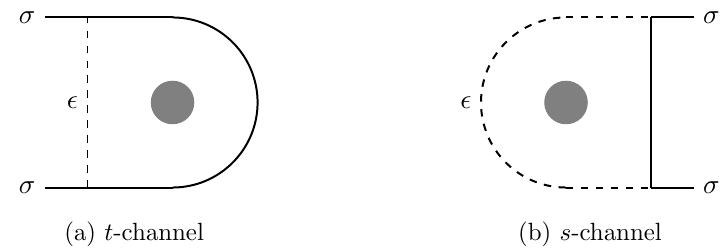
Figure 8. The asymptotic parts of the t -channel sum over [ (cid:27)(cid:27) ] n represented by the diagram on the left inverts to the s -channel process on the right. Accordingly, their inversion should produce poles for the [ (cid:15)(cid:15) ] m families. The diagram on the left is deciphered by reading it from left to right; (cid:12)rst the external (cid:27) operators fuse into [ (cid:27)(cid:27) ] n states, which exchange an (cid:15) to correct their self-energy (anomalous dimension), then they receive expectation values proportional to b 1 . The diagram on the right can also be deciphered by reading it from right to left; (cid:12)rst the external (cid:27) operators